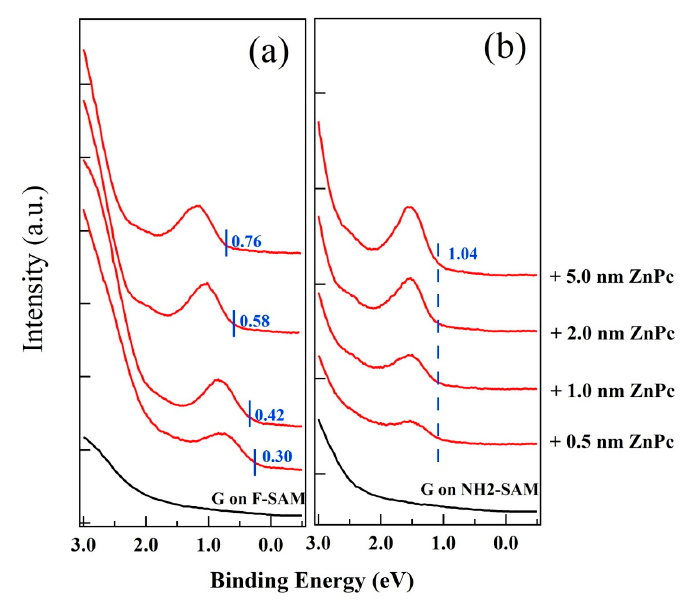
Figure 3. UPS spectra for the growth of ZnPc on ( a ) graphene/F-SAM and ( b ) graphene/ NH 2 -SAM.